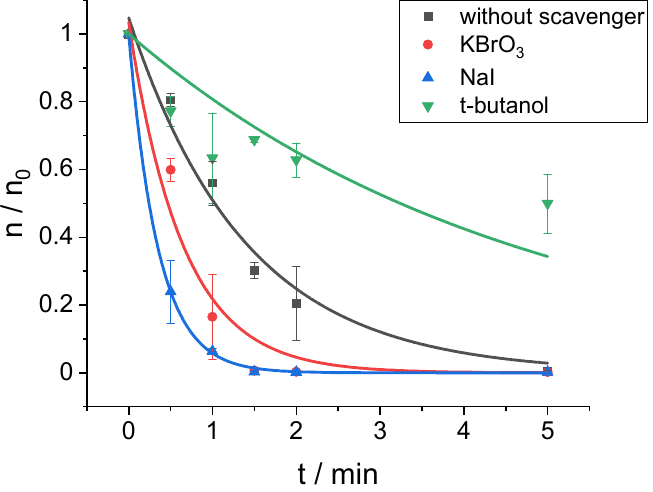
Figure 10. Reaction monitoring of the photocatalytic degradation of EE2 (17 α -ethinyl estradiol) and investigation of the influence of scavenger substances on the degradation kinetics. The experiment was carried out with a 60-fold parallel stirring UV-A LED photoreactor system [29], in which each value resembles a separate catalytic experiment, with triple determination; V EE2-solution = 5 mL, c = 4.5 mg L − 1 ; scavenger additives: NaI, KBrO 3 , t-butanol, c scavenger = 3 mmol L − 1 ; reaction parameters: catalyst P25 (calcined), mP25 = 7.5 mg, f rot = 800 min − 1 , t dark = 30 min, E = 384 mW cm − 2 , λ = 365 nm; SPE-GC-MS analysis (determination of ion count n as a measure of the amount of substance from the extracted ion current (EIC), precursor ions: [M] + 440 m / z , [M-15] + 425 m / z ; k(without scavenger) = 0.012 s − 1 , k(KBrO 3 ) = 0.026 s − 1 , k(NaI) = 0.048 s − 1 , k(t-butanol) = 0.004 s − 1